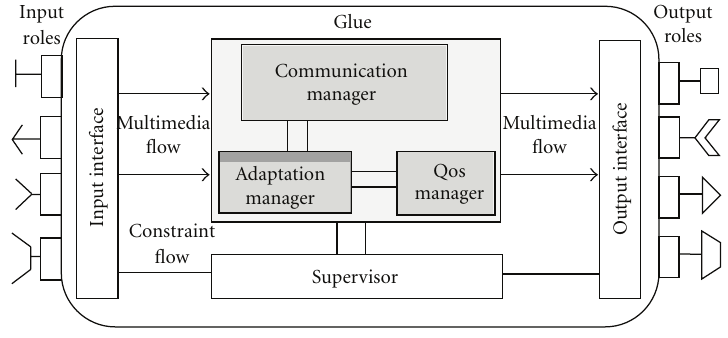
Figure 16: Model of multimedia connector.